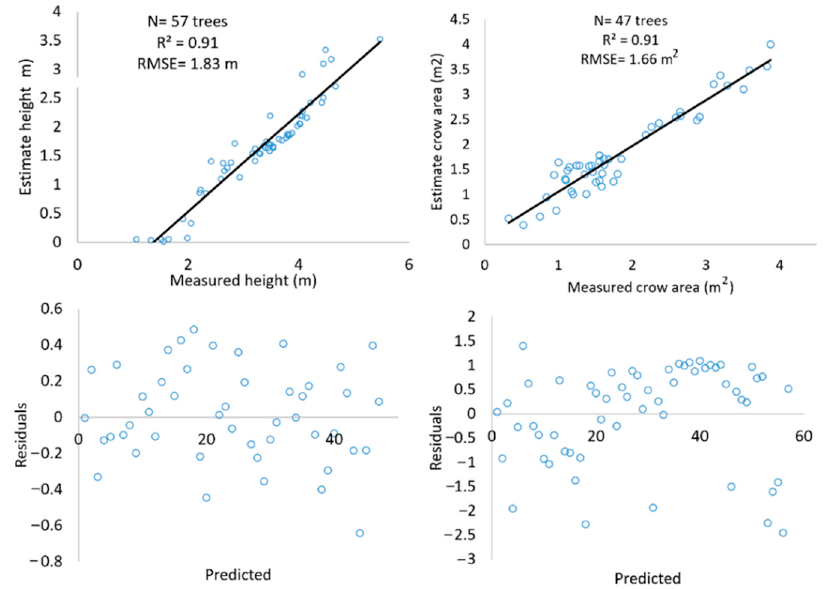
Figure 5. Regression analysis ( top ) and graph of residual vs. predicted values ( bottom ) for height ( left ) and crown delineation ( right ), at individual tree level with field data and estimates derived from the UAV, from 57 trees detected with the ForestTools algorithm.